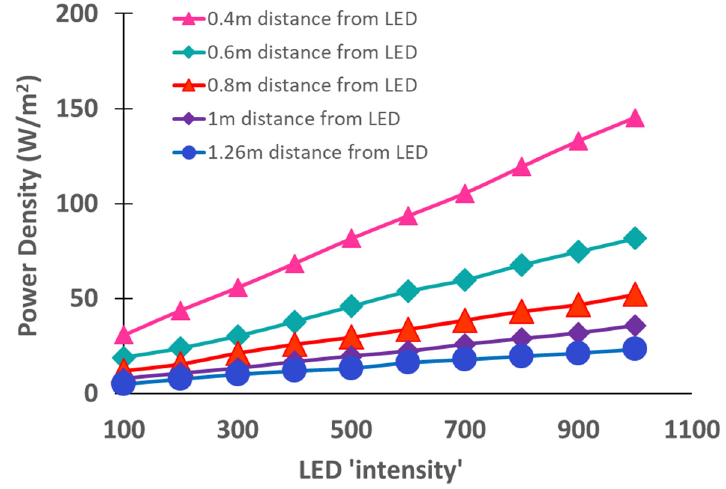
Figure 2. LED power density versus LED intensity for different distances from the LED source. The power density of the LED grows light is typically measured using a LaserCheck optical power meter to varying distances from the LED source.